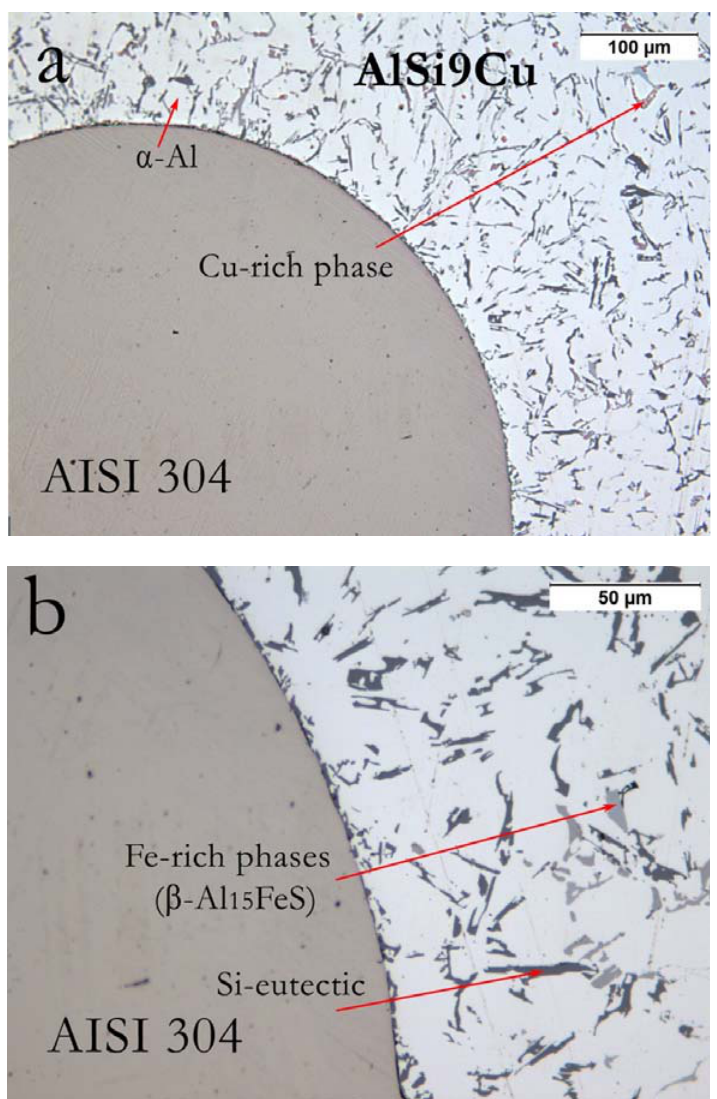
Figure 5: Optical micrographs of the two alloys and their coupling interface in the as-cast condition at different